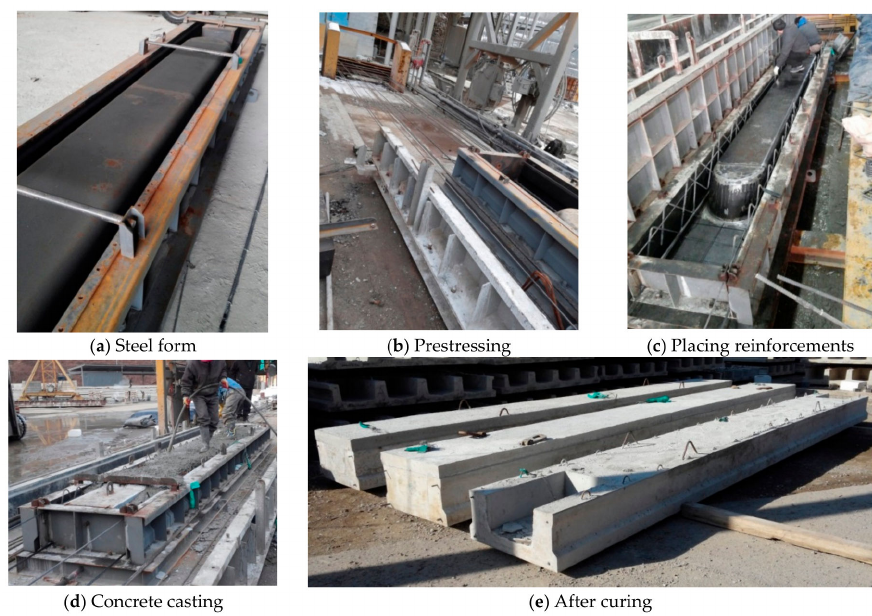
Figure 2. Manufacturing process of OPS.